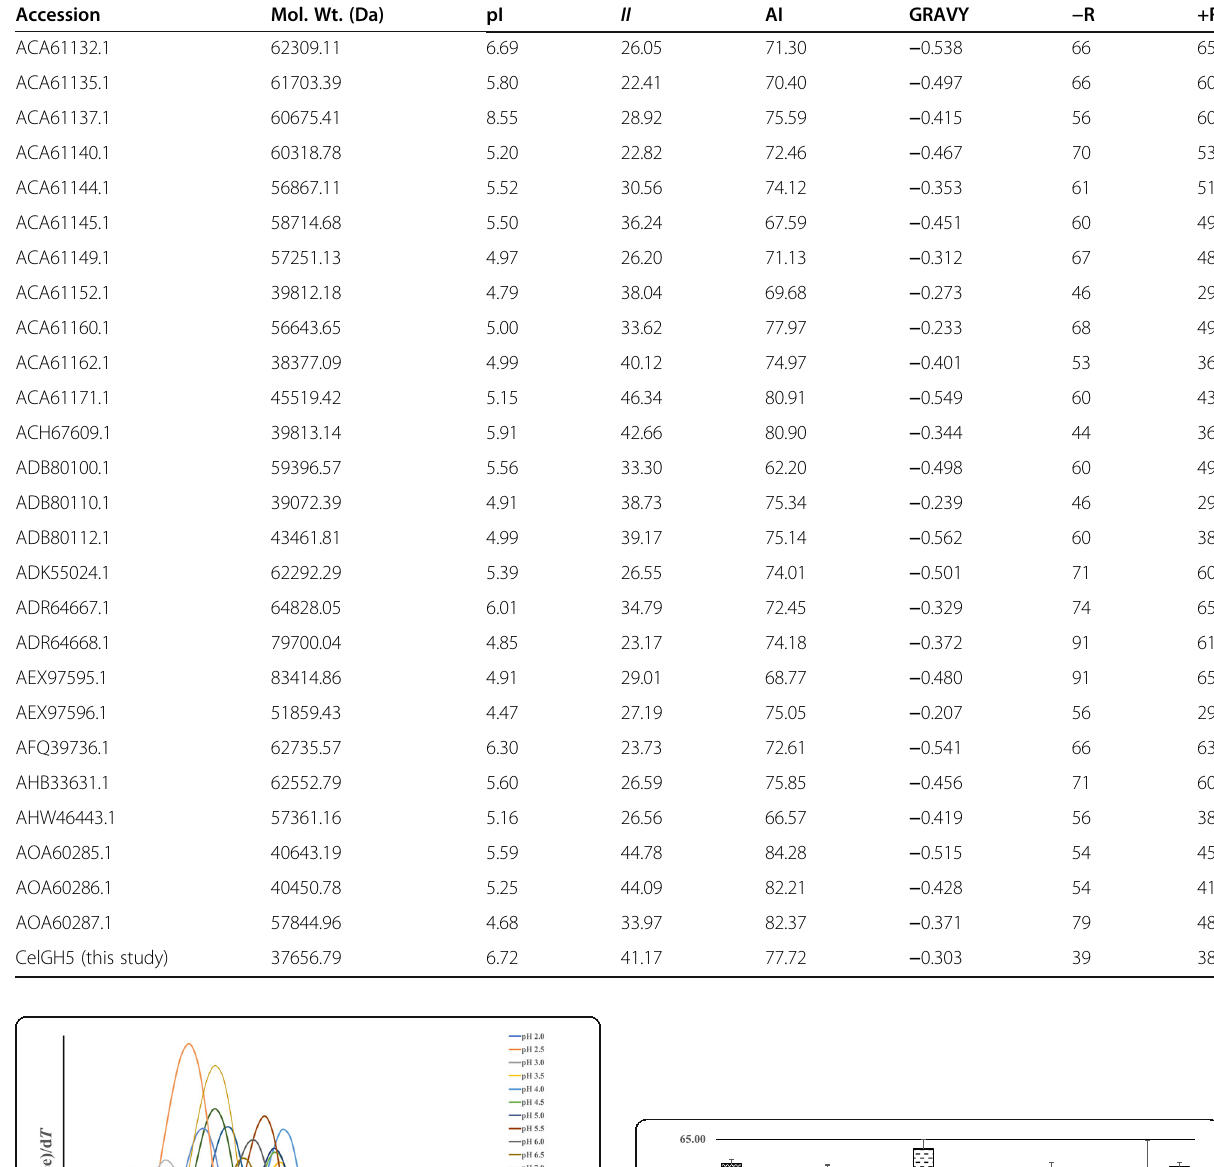
Table 2 Physicochemical properties computed using ExPASy-ProtParam tool Accession